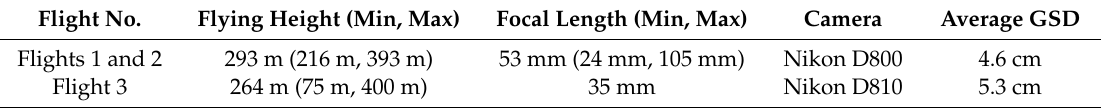
Table 1. All relevant parameters of the three test